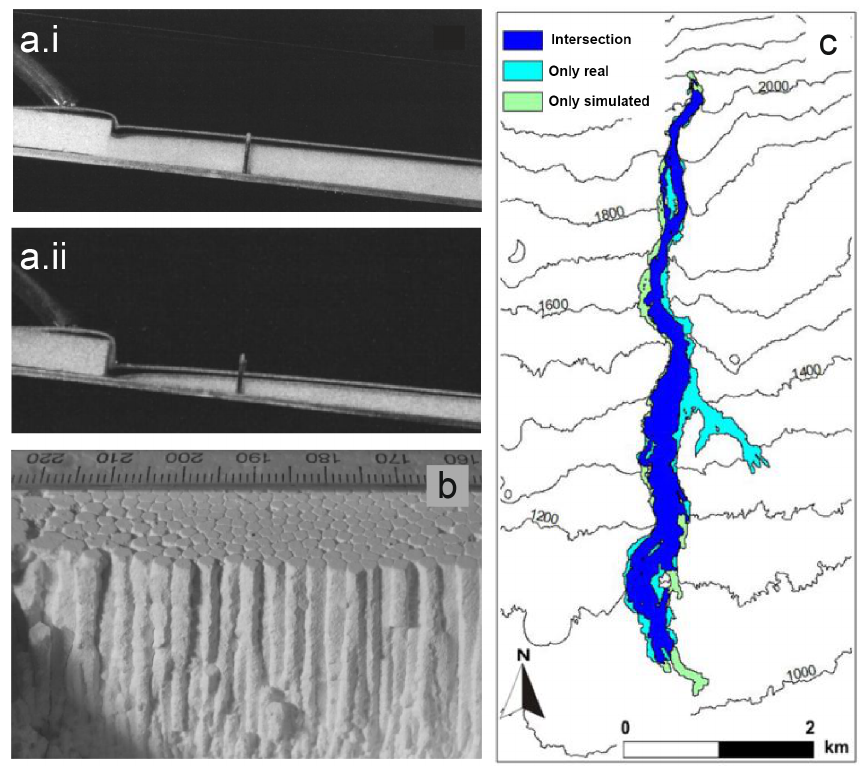
Figure 12. Analogue models and numerical simulations of lava flows. (a) Effusion of molten wax onto bed of solid wax to study thermal erosion of lava flow into underlying material after (i) 4 and (ii) 14min (modified from Kerr, 2001). (b) Dehydration of corn starch–water slurry to study the formation of columnar jointing structures in lava flows (modified from Goehring et al., 2006). (c) Cellular automata model of lava flow inundation (green and dark blue) compared with the flow path of the natural lava flow (light blue and dark blue) effused at Mt Etna, Italy (modified from Rongo et al.,